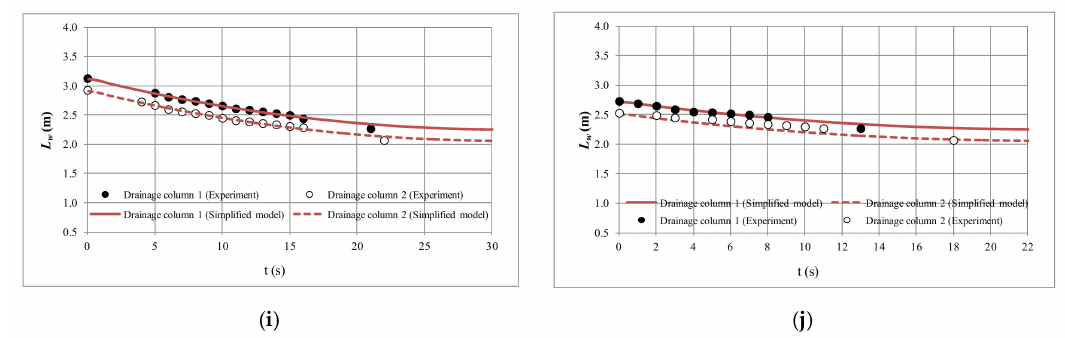
Figure 5. Comparison between measured and calculated water column lengths evolution, ( a ) Run No.